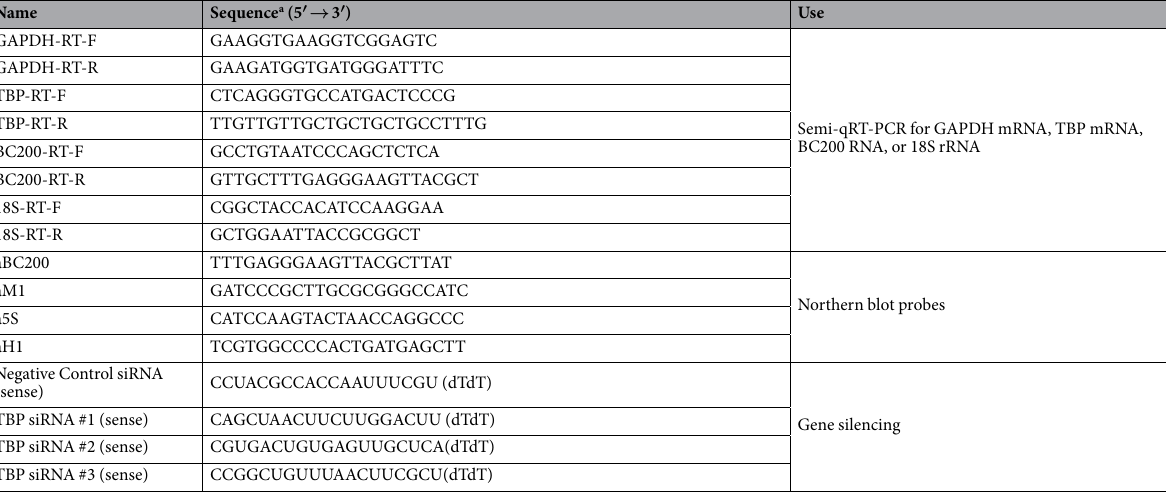
Table 3. Oligonucleotides used in this study. a Restriction sites are